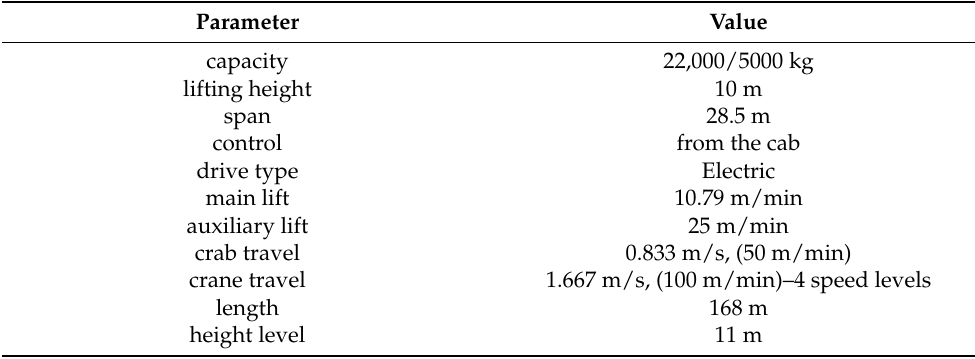
Table 1. Technical parameters of the bridge crane.